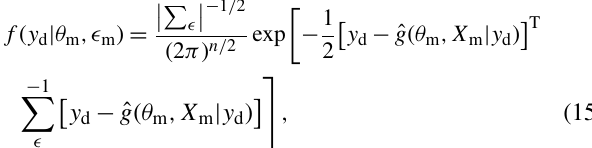
Figure 6. Two-dimensional spatial distribution of the horizontal wind velocity variance ( σ 2 normalized with the u -velocity variance of the ambient wind field ( σ 2 neutral, and (c) unstable conditions. Approximately 298 scans of the wake are processed for each 10min period. The relative ambient wind speed ranges between 6.5 and